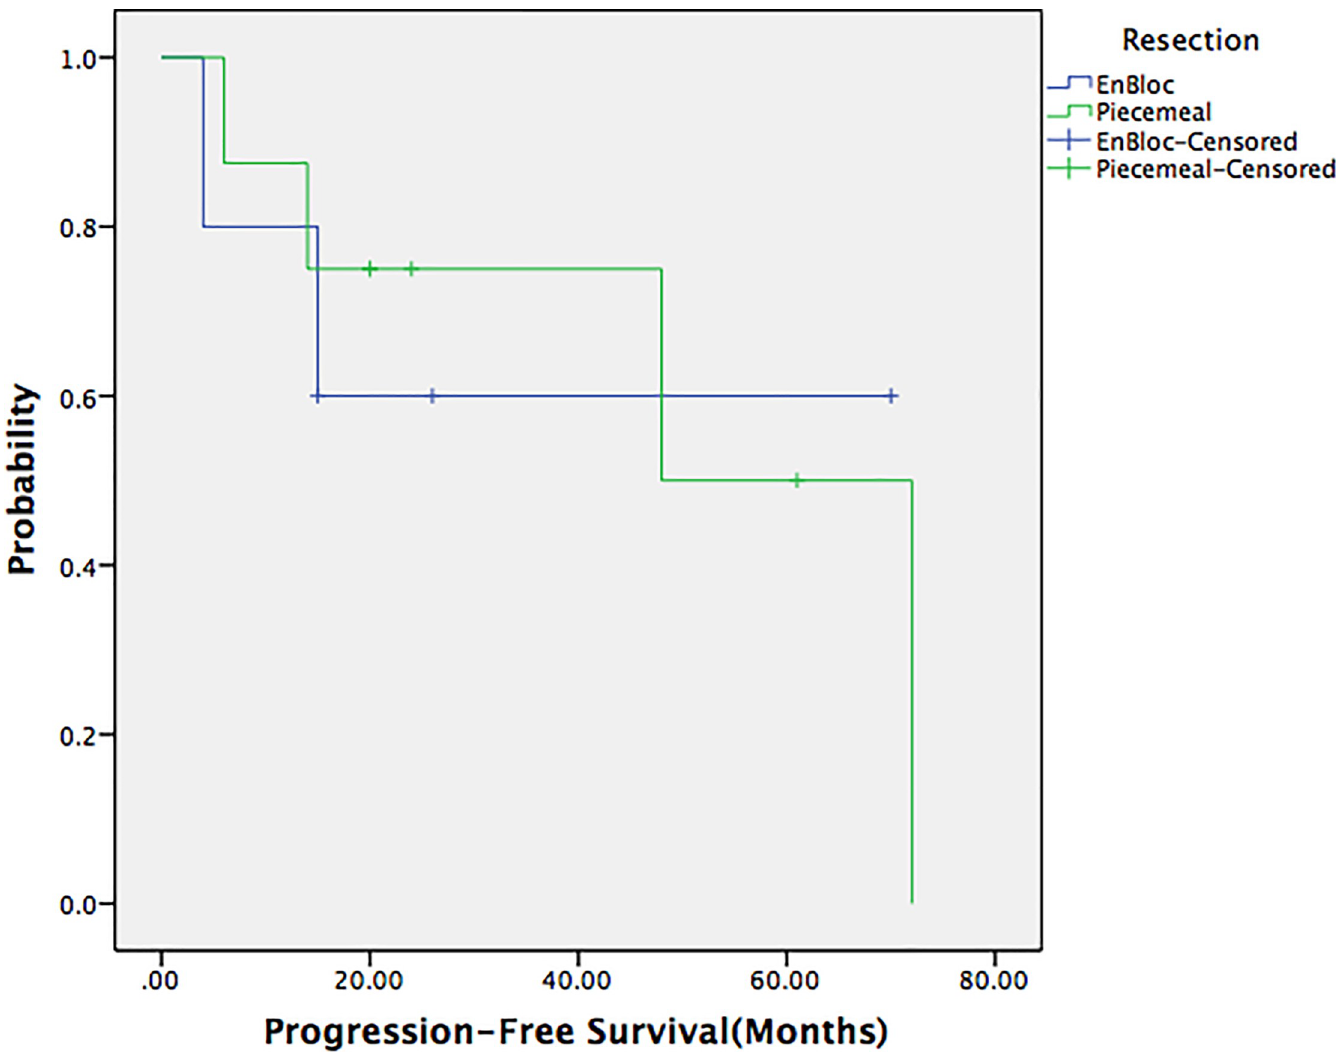
Fig 3. Progression-free survival curves of patients with en bloc resection and piecemeal resection. There was no significant difference between the two groups ( p = 0.97).